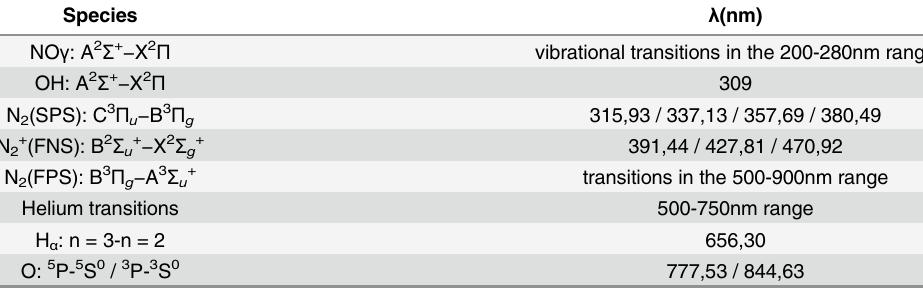
Table 1. Main emissive species produced with Helium as plasma carrier